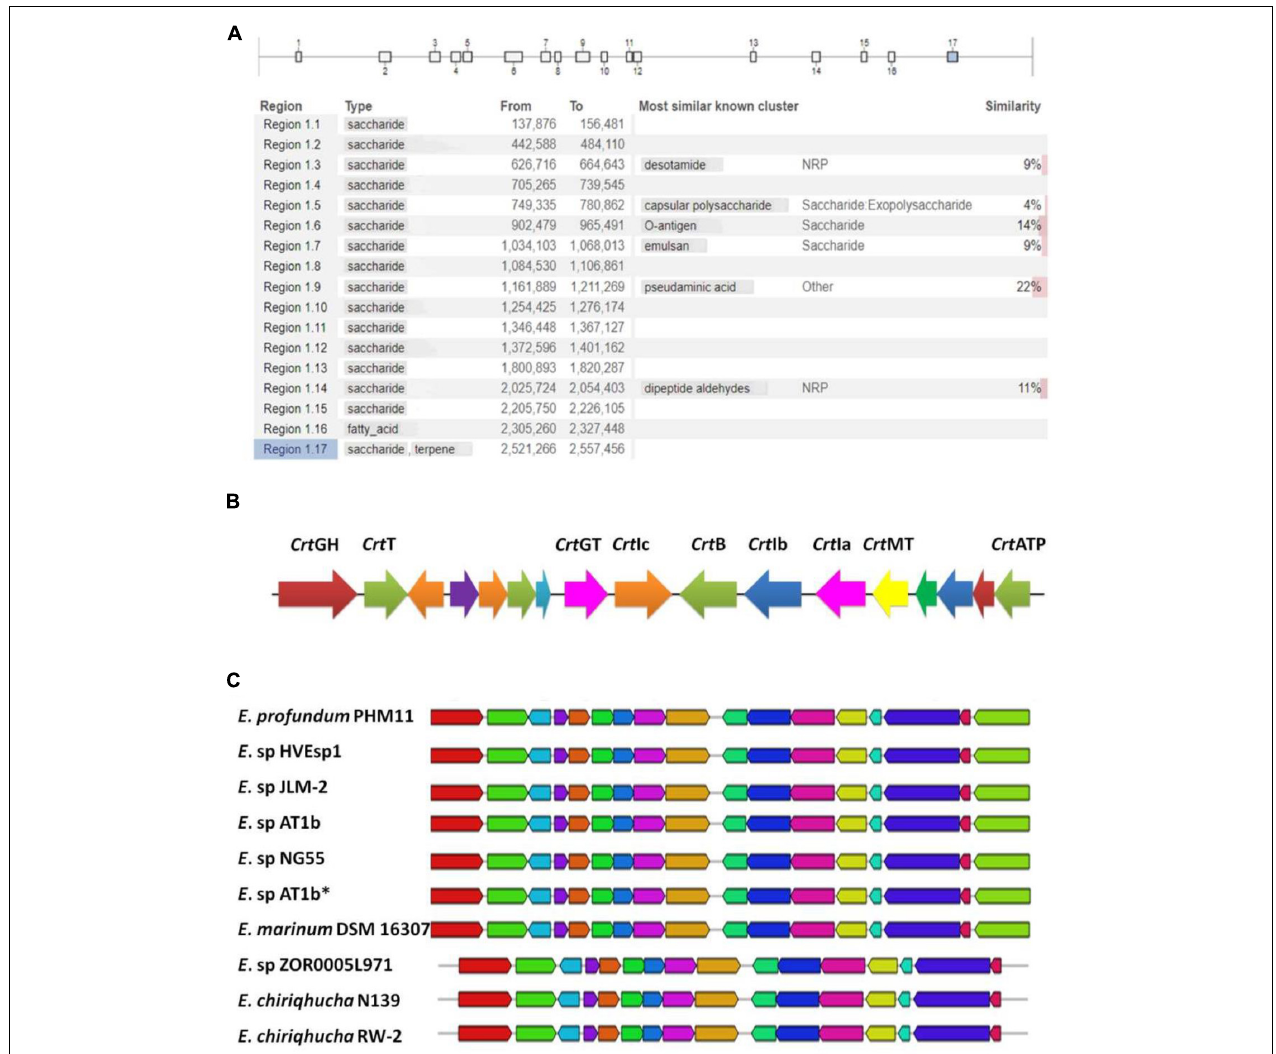
FIGURE 2 | Identification of putative biosynthetic gene clusters (BGCs) using anti-SMASH. (A) Represents the presence of the 17 BGCs across the Exiguobacterium profundum PHM11 genome. (B) Represents the 17th cluster of the BGC representing the phytoene synthase ( crtB ), phytoene desaturase ( crtI ), glycoside hydrolase ( crtGH ), MATE family efflux transporter ( crtT ), glycosyltransferase ( crtGT ), phytoene desaturase ( crtIa , crtIb , crtIc ), phytoene synthase ( crtB ), class I SAM-dependent methyltransferase ( crtMT ), and ATP-binding cassette domain-containing protein ( crtATP ). (C) Represents the conservation of the clusters in different Exiguobacterium spp. ‘*’ is used to differentiate Exiguobacterium sp. AT1b submitted with accession number MOEL01 (Assembly GCA_001908175.1) in the NCBI